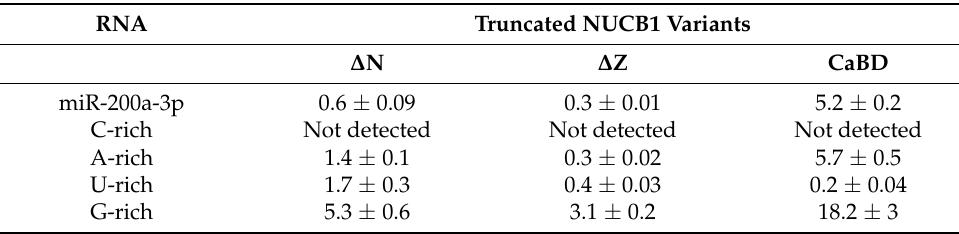
Table 4. The K D (nM) of complexes formed by the NUCB1 variants with RNAs.